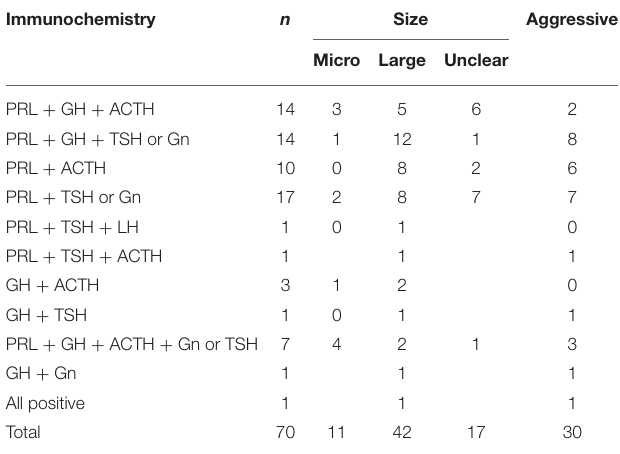
TABLE 1 | The combination of immunohistochemistry and its relationship with tumor size and